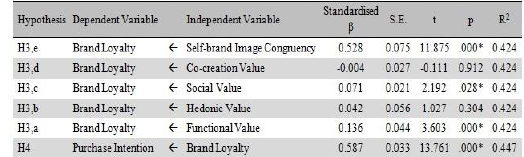
Table 3: Estimation Statistics of the Second Structural Equation Model